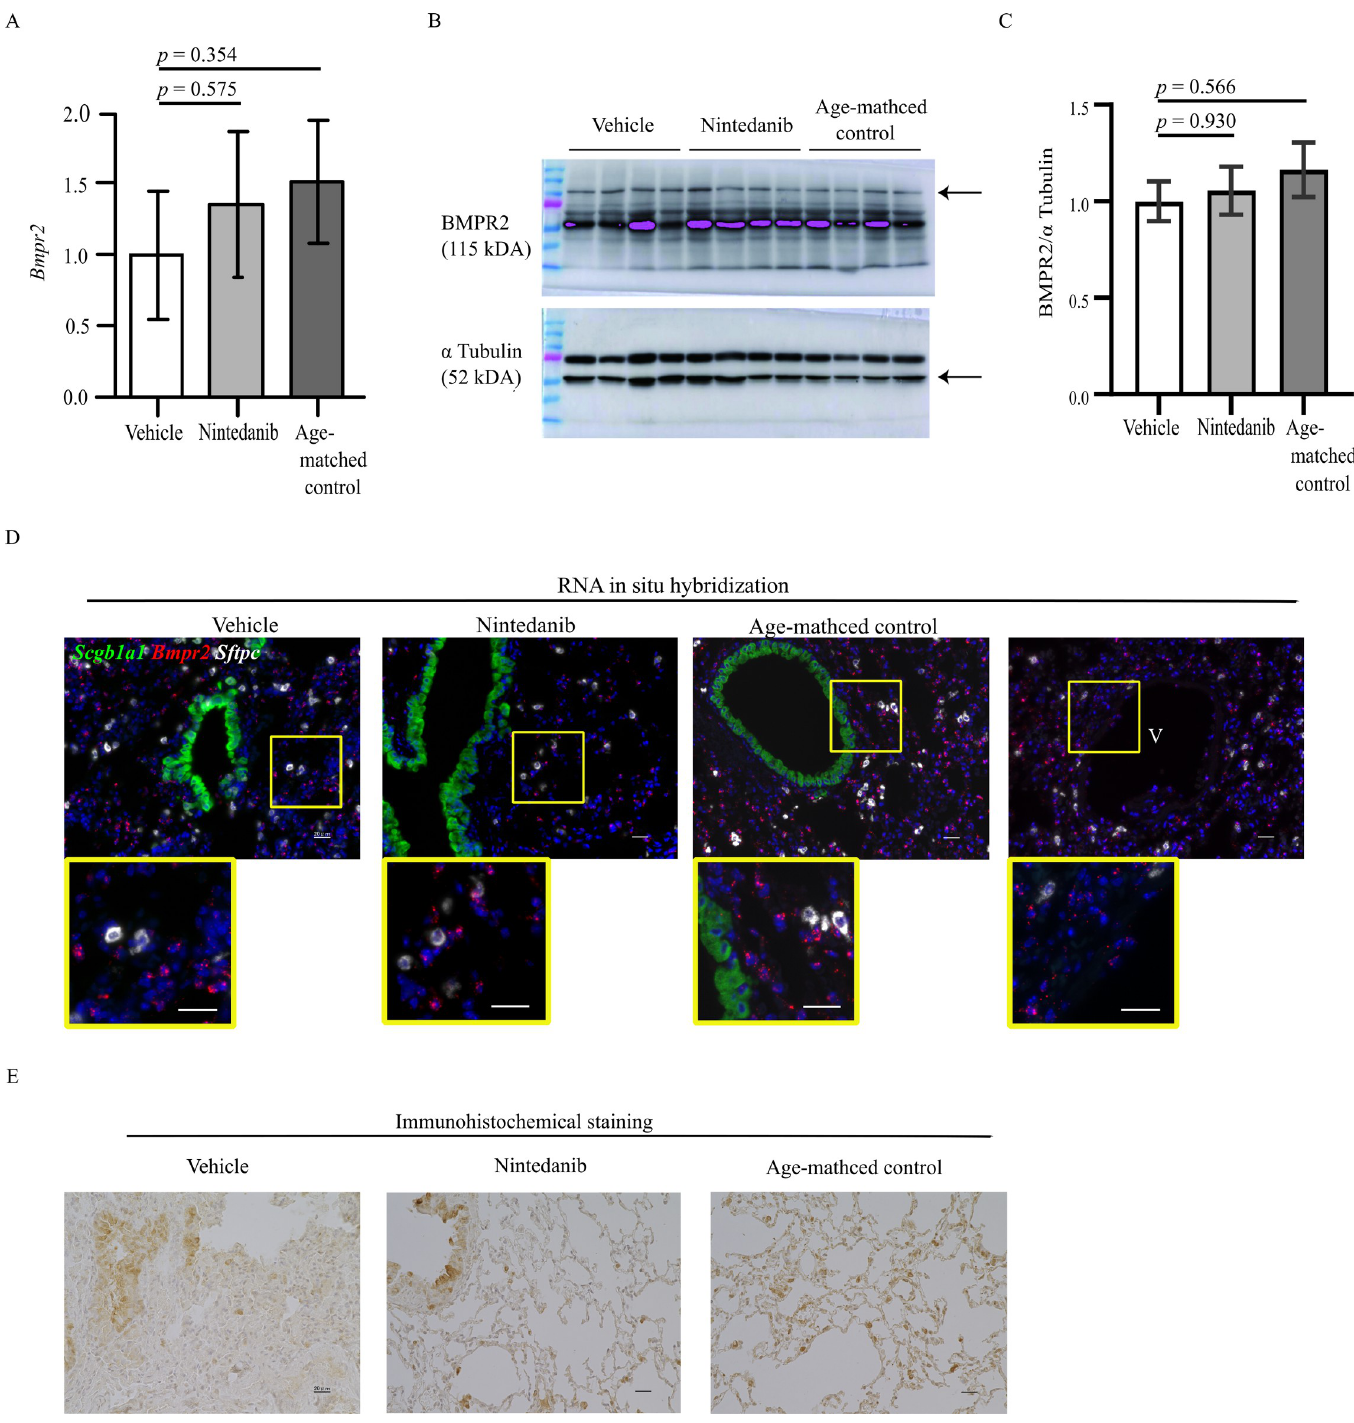
Fig 5. Bmpr2 expression in the lung. (A–C) Bmpr2 expression in vehicle-treated, nintedanib-treated, and age-matched lung tissue. (A) Quantitative reverse transcription polymerase chain reaction analysis showed that Bmpr2 expression tended to be downregulated in vehicle-treated mouse lung (n = 3) compared with that in age-matched D1CC × D1BB mouse lung (n = 3) and that this downregulation tended to be attenuated by nintedanib treatment (n = 3). The vehicle- and nintedanib-treated mouse lungs were obtained from the mice used in the analysis shown in Fig 1C. (B, C) Western blot analysis confirmed the findings shown in (A): matched D1CC × D1BB mouse lung, n = 4; vehicle-treated mouse lung, n = 4; nintedanib-treated mouse lung, n = 4 Relative signal intensity was determined using α Tubulin as the loading control. Data are presented as mean ± standard error. (D) RNA in situ hybridization for Bmpr2 expression in the peripheral lung. Bmpr2 was expressed mainly in type I alveolar epithelial cells adjacent to type II alveolar epithelial cells with Sftpc expression. Scale bars = 20 μ m; V, blood vessels. (E) Immunohistochemical staining revealed that BMPR2 localized to some bronchial epithelial cells and alveolar epithelial cells. Scale bars = 20 μ m.